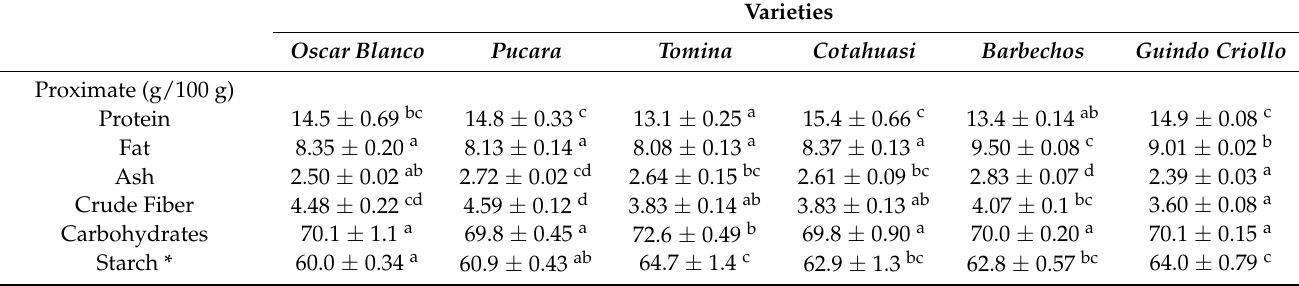
Table 2. Proximate and mineral composition of six Amaranthus caudatus varieties. Concentrations are presented in dry weight (dw), as mean ± standard deviation ( n = 3). For each compound, different superscript letters in rows indicate significant differences between the amaranth varieties (Tukey’s test, p <